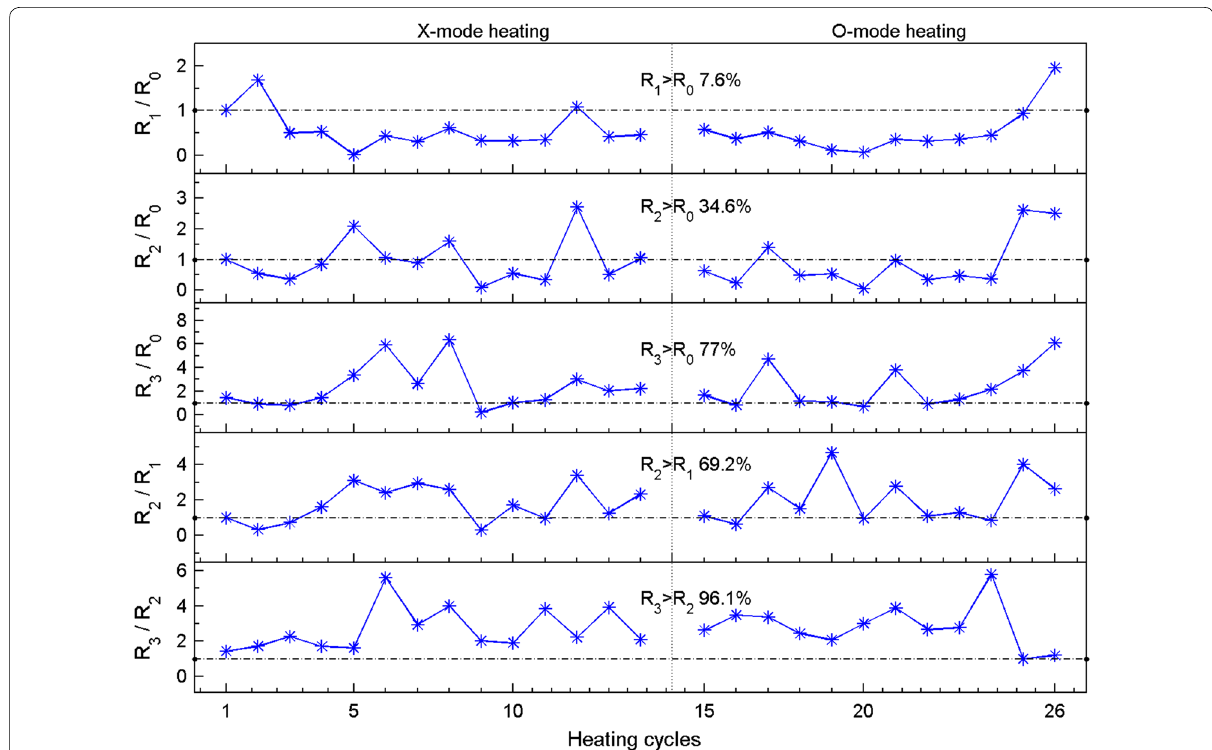
Fig. 4 As for Fig. 3 but for case 2. In this case, the HF transmitter was operated with one frequency 5.423